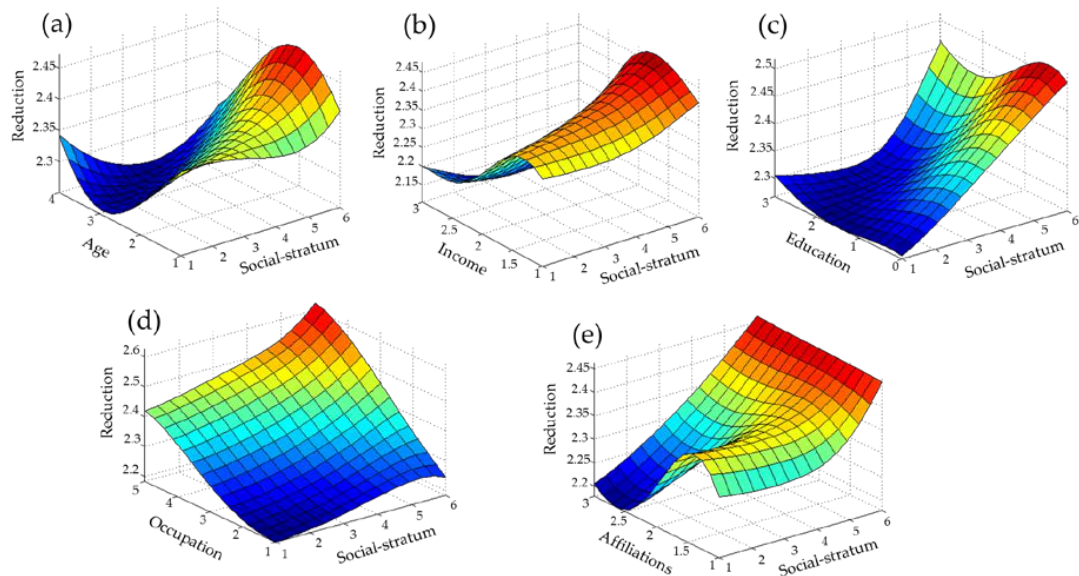
Figure 3. Reduction practices in consumption. Relationship between social stratum and ( a ) age; ( b ) monthly income; ( c ) education; ( d ) occupation; and ( e ) affiliations.